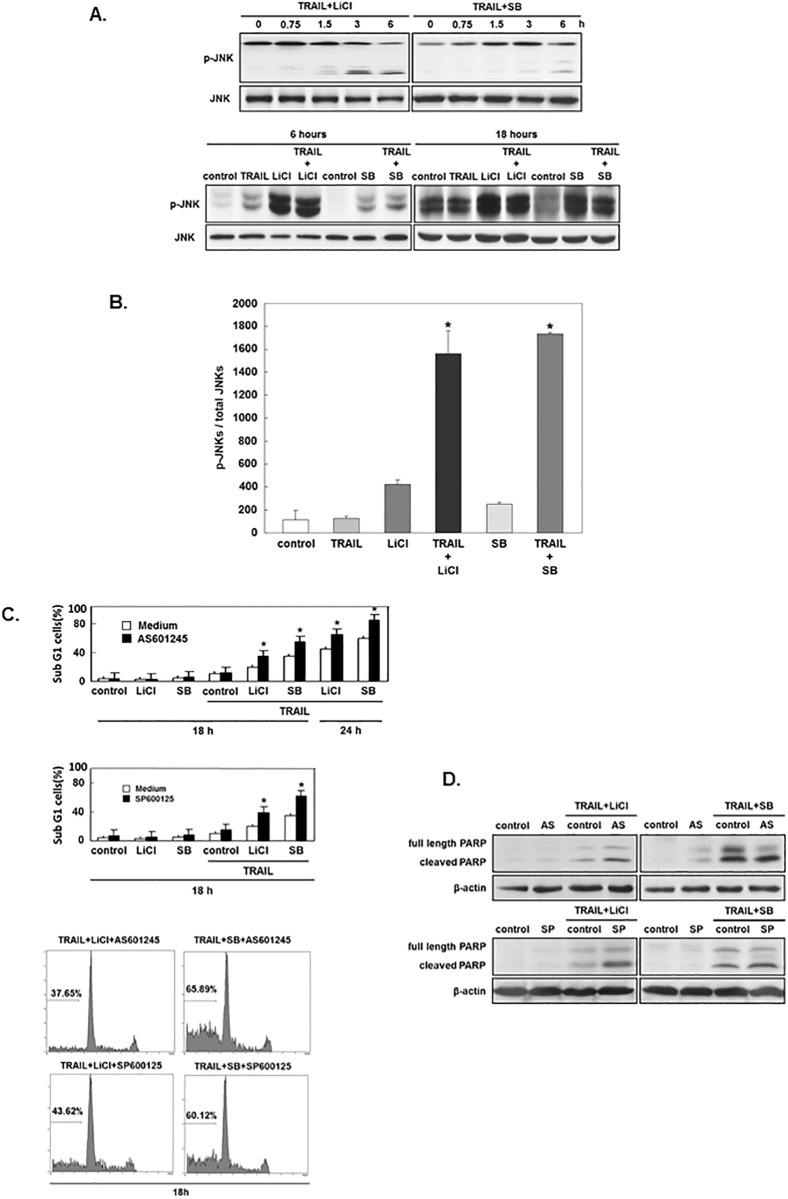
JNKs limit the extent of GSK-3 inhibitor sensitization of TRAIL-induced apoptosis.(A) AGS cells were treated with or without TRAIL (25 ng/mL), lithium (LiCl, 20 mM) and/or SB-415286 (SB, 25 μM) for 18 hours. Total AGS extracts (40 μg) were analyzed for phosphorylation and total level of JNK by Western blotting. (B) 6 hours of treatment and calculation of phosphorylated form/total JNK ratio. The quantitative value is the mean ± the standard error (SE) of four independent experiments. *, p < 0.05 compared to cells treated with GSK-3 inhibitor only. (C) LiCl (20 mM), SB (25 μM) or JNK inhibitor (AS601245 2 μM or SP600125 5 μM), with or without TRAIL (25 ng/mL) of sub-G1 cells. Blots are representative of three independent experiments and the results are referenced to ±the standard error (SE). *, p < 0.05 compared to cells treated with GSK-3 inhibitors and TRAIL in four independent experiments. (D) AGS cells treated with or without LiCl (20 mM), SB (25 μM), JNK inhibitor (AS601245 2 μM or SP600125 5 μM), or TRAIL (25 ng/mL). PARP cleavage was analyzed by Western blotting.